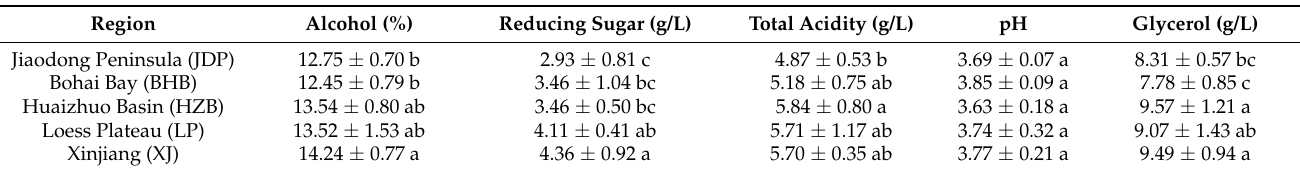
Table 1. Basic parameters of Marselan wines from different regions of China *.